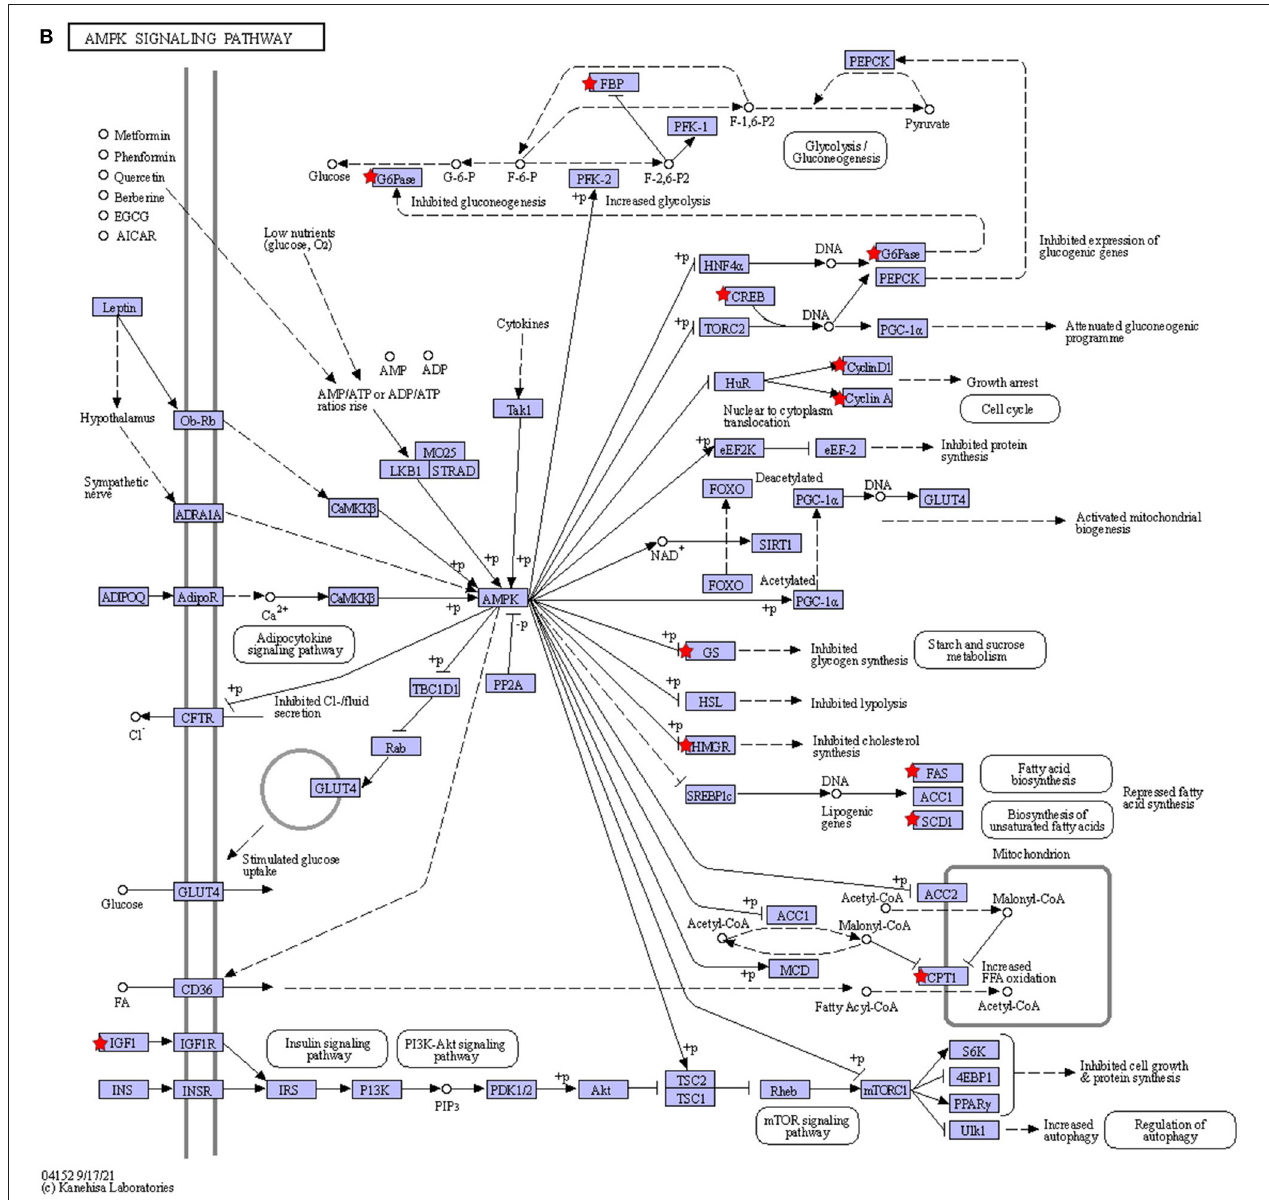
FIGURE 7 | The location of the DEGmRNAs in the significantly enriched pathways. Diagram of the PPAR signaling pathway (A) and AMPK signaling pathway (B) . The red pentagram represents